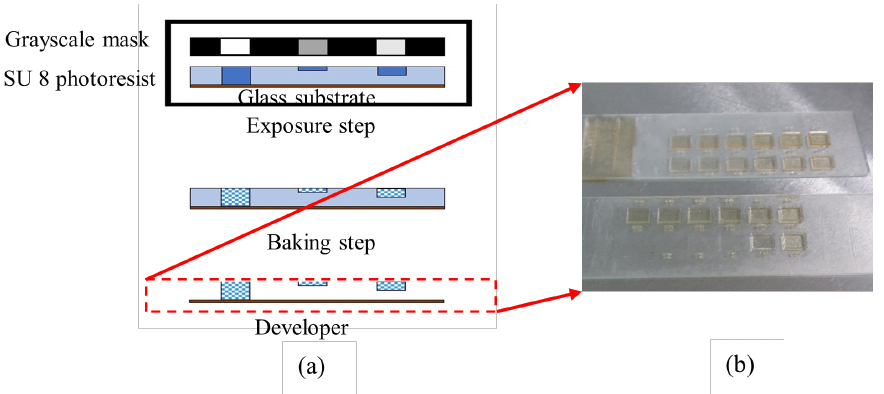
Figure 3. ( a ) Grayscale fabrication method and ( b ) real image of SU8